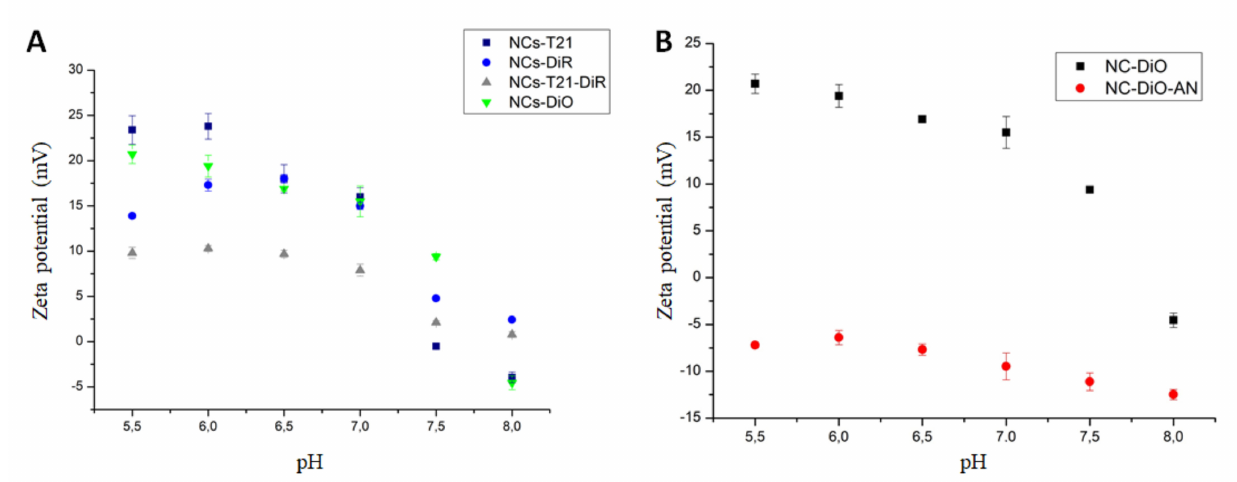
Figure 2. Zeta potential measurements. ( A ) Zeta potential values of 4 samples of NCs and ( B ) comparative analysis to a control NCs